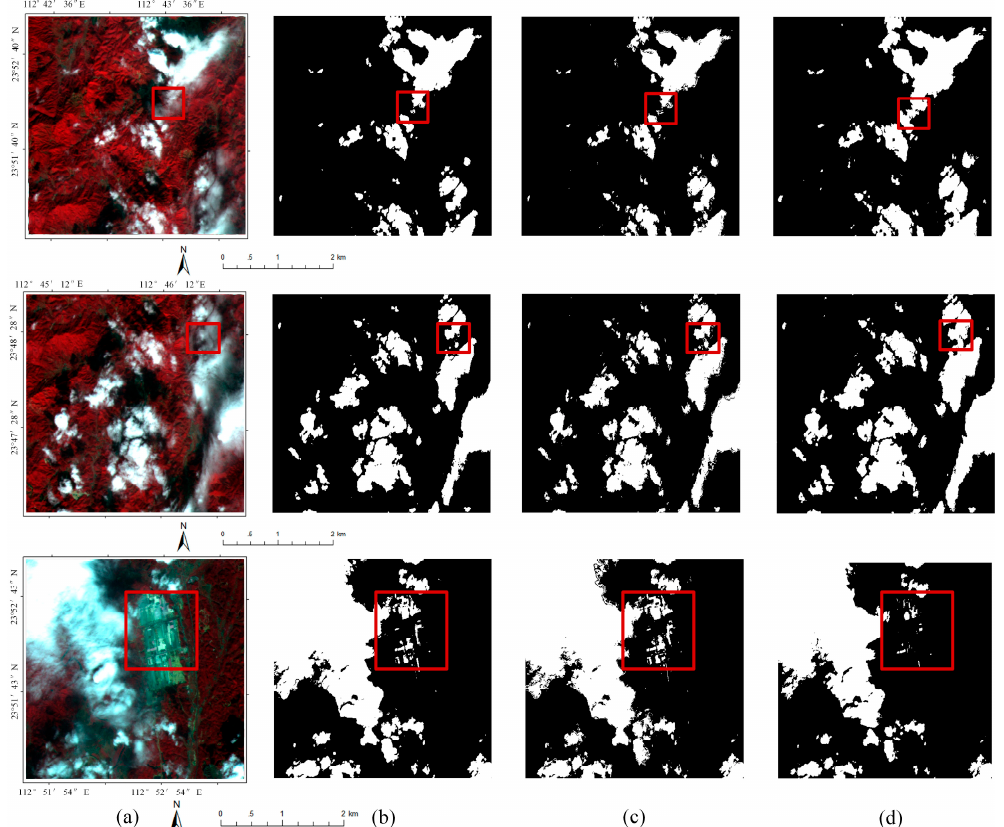
Figure 8. ( a ) Pseudo color GF-1 image with combination of band 4-3-2; and ( b – d ) the cloud detection